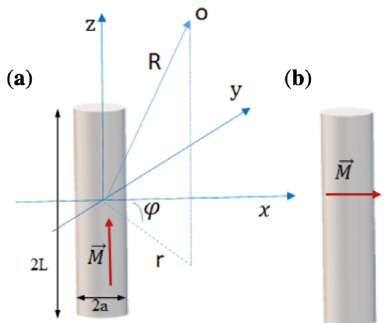
Figure 1. Principle directions and quantities for field calculations of a uniformly magnetised cylinder: ( a ) axial magnetisation; ( b ) diametrical magnetisation.